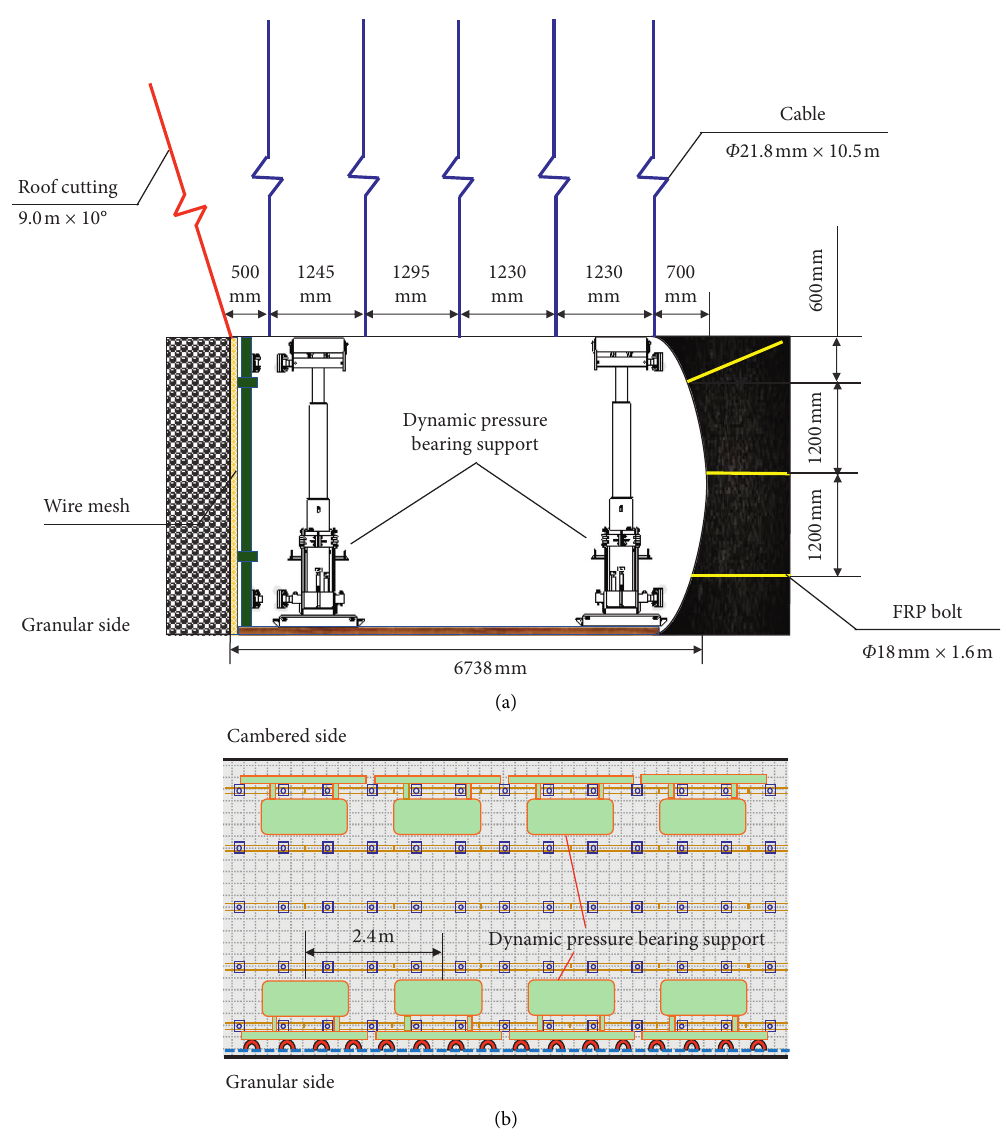
Figure 12: Design parameters for the dynamic bearing support in front of the working face: (a) cross-section diagram and (b) plan